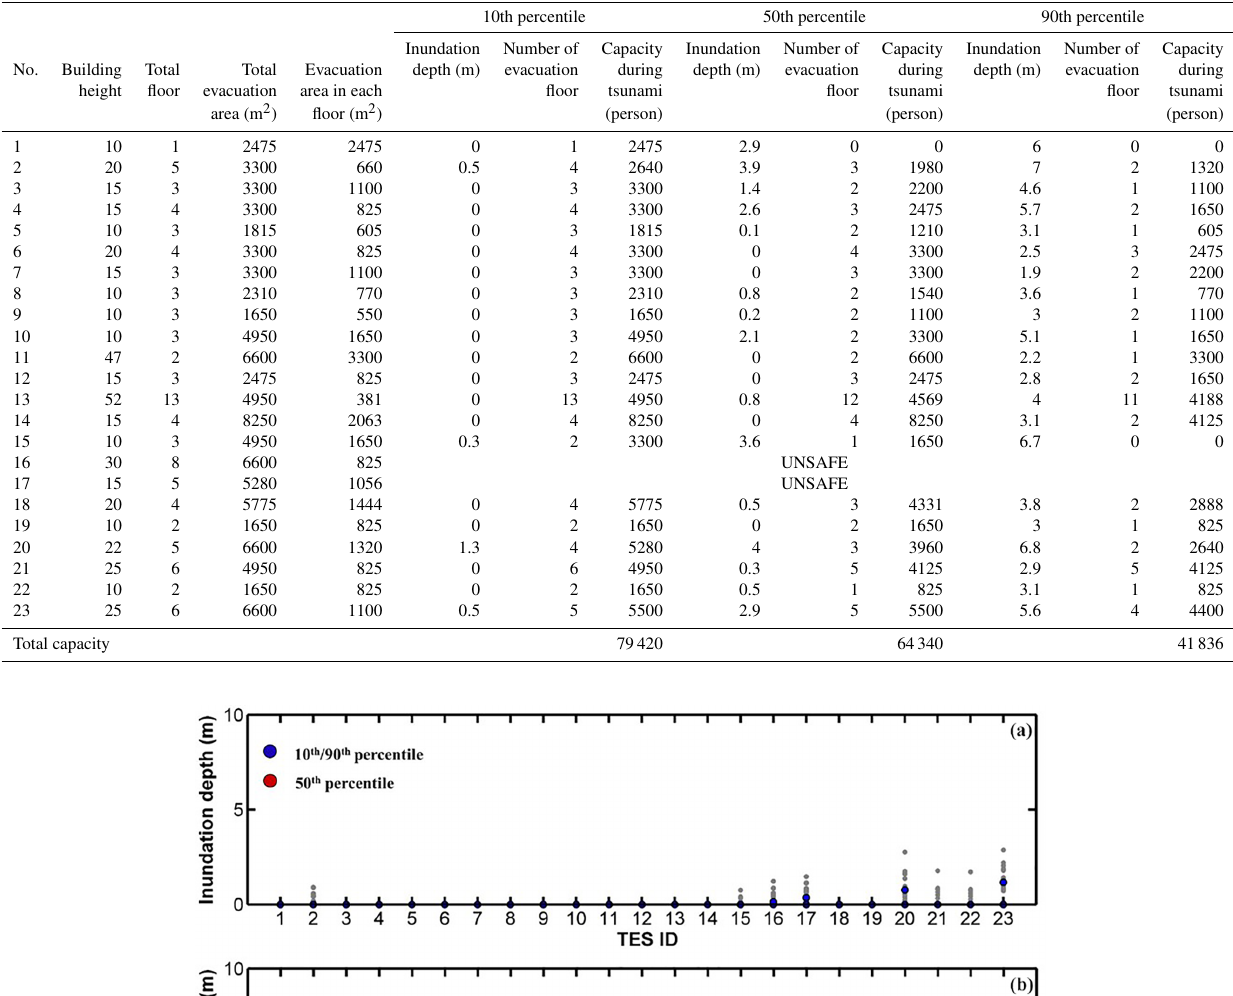
Table 6. TES building capacity during the tsunami event considering the M w 9.0 scenario.